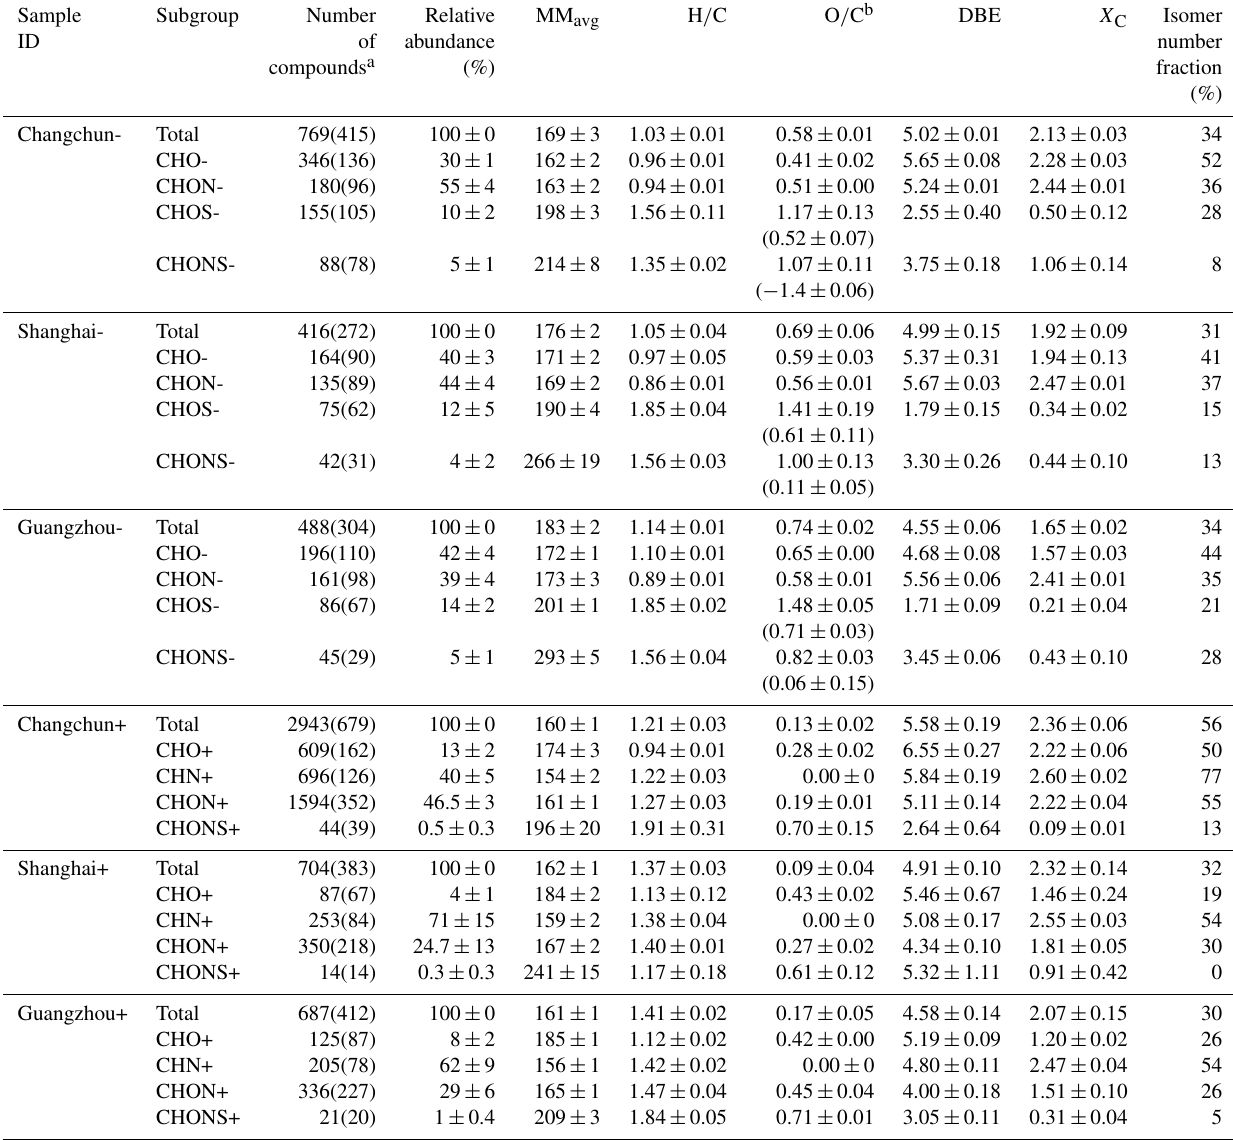
Table 1. Number of organic compounds and molecular formulas in each subgroup and the peak abundance-weighted average values of molecular mass (MM avg ), elemental ratios, double bond equivalent (DBE), aromaticity equivalent ( X C ) and isomer number fraction (meaning the percentage of formula numbers that have isomers among all assigned formulas) for detected organic compounds in ESI- and ESI+ in the three Chinese